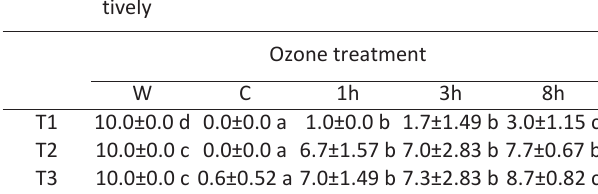
Values in the same row followed by different letters differ signifi- cantly (significance was set at